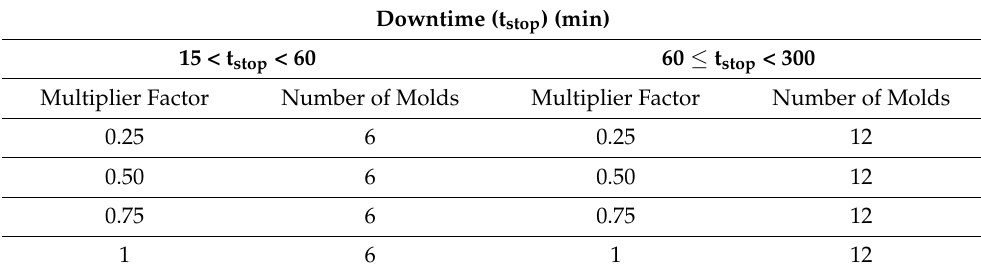
Table 2. Operating modes of staggered additions in prolonged